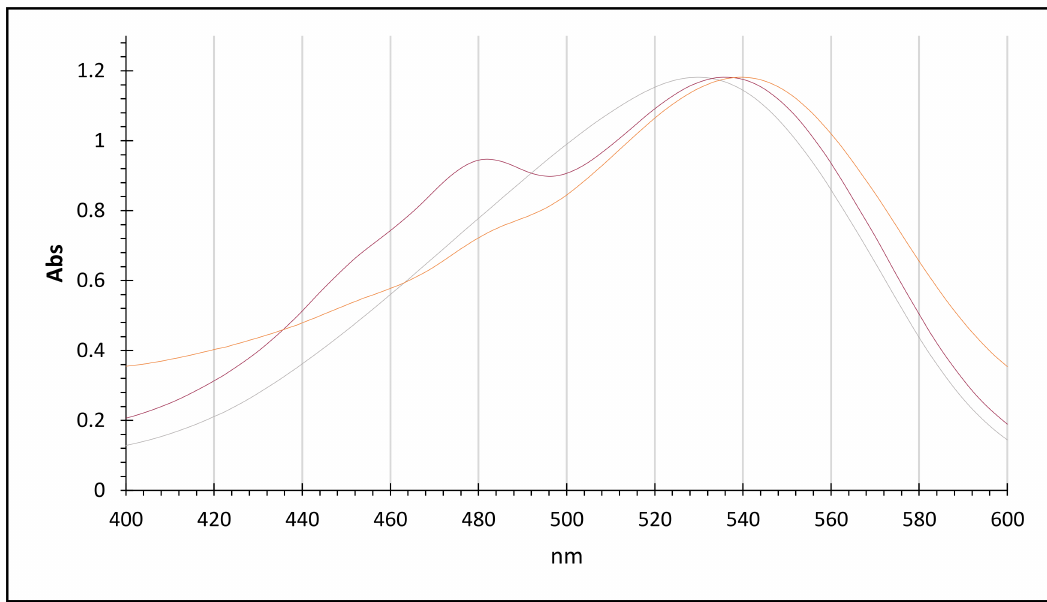
Figure 7. The three UV-Vis spectra of betanin: commercial pigment—grey line, natural pigment (beet juice)—red line, natural pigment after recovery—orange